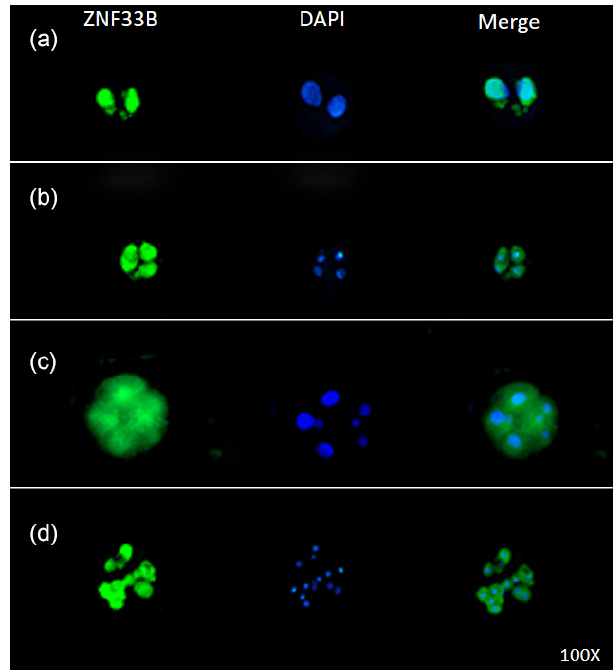
Figure 4. Expression of ZNF33B in bovine early embryos. (a– d) Expression of ZNF33B in 2-, 4-, 8-, and 16-cell embryos, re-